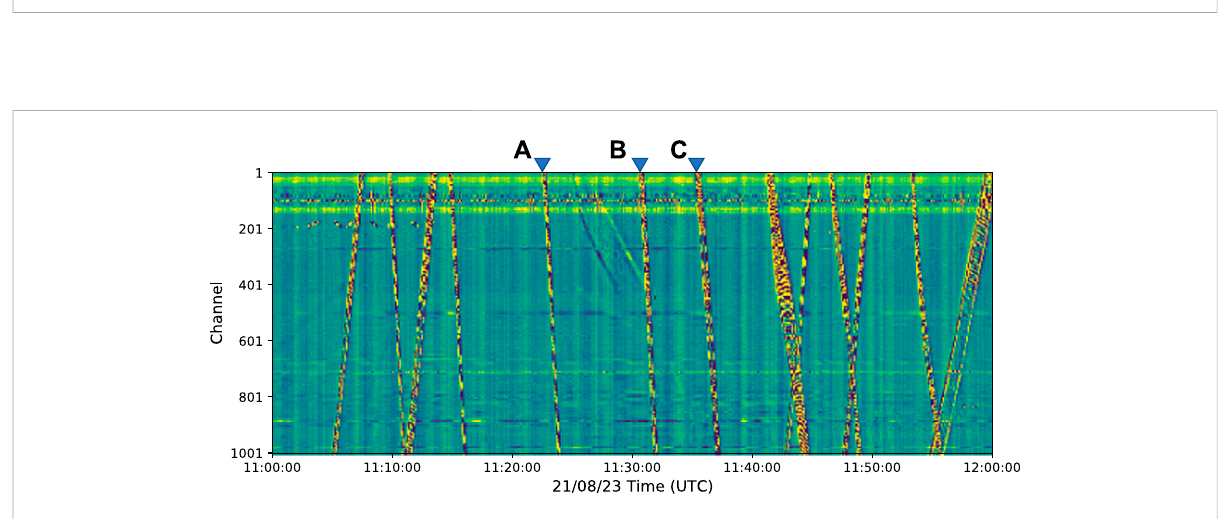
FIGURE 2 One-hour DAS data records under a heavy railway traf fi c scenario. The reverse blue triangles mark three typical train events shown in Figure 3 (corresponding to (A – C) from left to